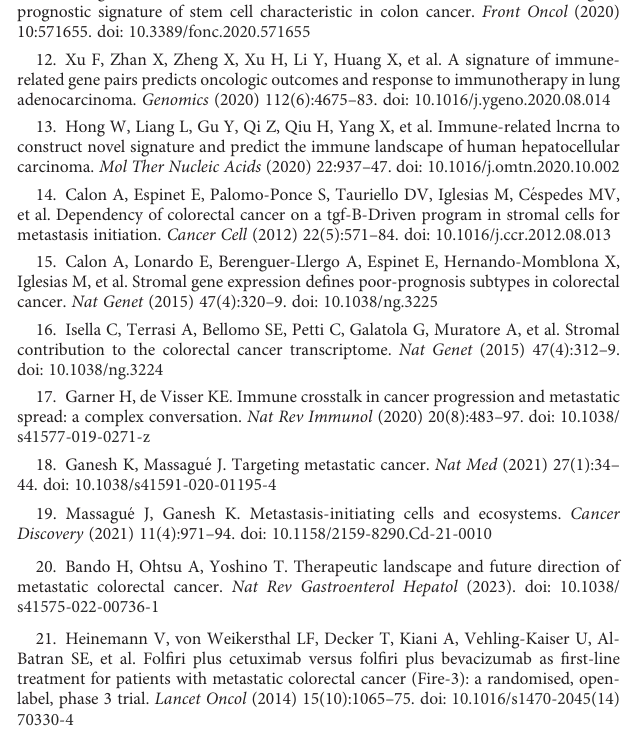
SUPPLEMENTARY FIGURE 1 The relationship between immune cells and risk scores in validation cohorts. After immune assessment of the validation set by ssGSEA, multiple immune cells including antigen-presenting cells were highly in fi ltrated in the high-risk score group in the (A) GSE39582, (B) GSE17536, and (C) GSE29621. SUPPLEMENTARY FIGURE 2 Relationship between CTSW/FABP4 and clinicopathological features and cell invasion ability. TCGA-CRC samples were divided into high and low groups according to the median expression of CTSW/FABP4, and the relationship between age, gender, stage, TNM stage and grouping were analyzed (A, B) . Transwell assay to explore the invasion ability of CRC cells after CTSW/FABP4 knockout (C) . * p < 0.05; ** p < 0.01; *** p <